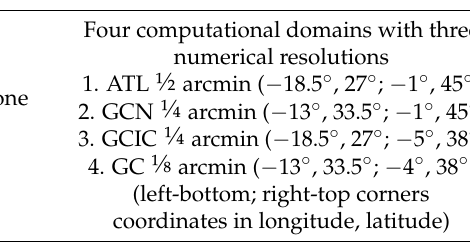
Table 2. Comparison of operational parameters at the National Tsunami Warning System of Spain for tsunamis generated in the Gulf of Cadiz and at the ChEESE live demo.